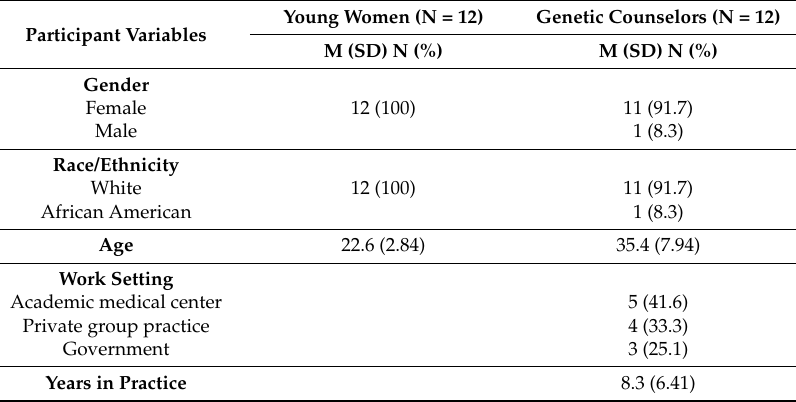
Table 2. Participant characteristics.